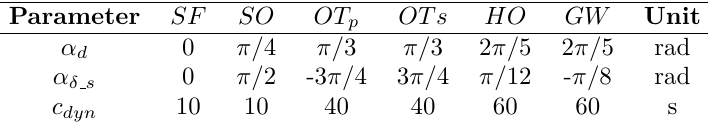
Table 1: Rule-based parameters for the TS domain.